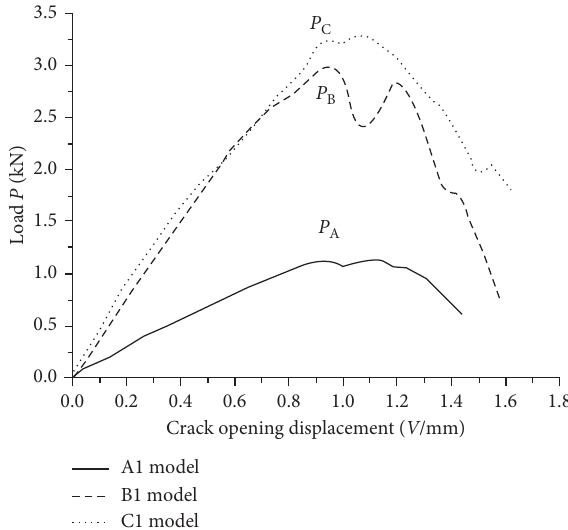
Figure 15: P - V curve of the three-point bending